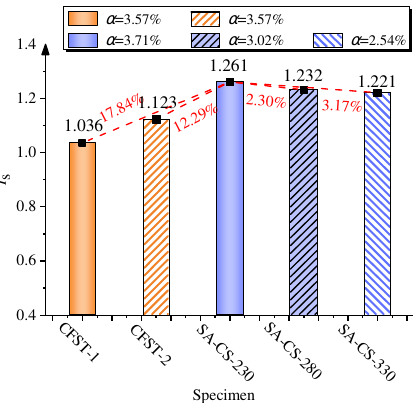
Figure 8. Strength index of core concrete.